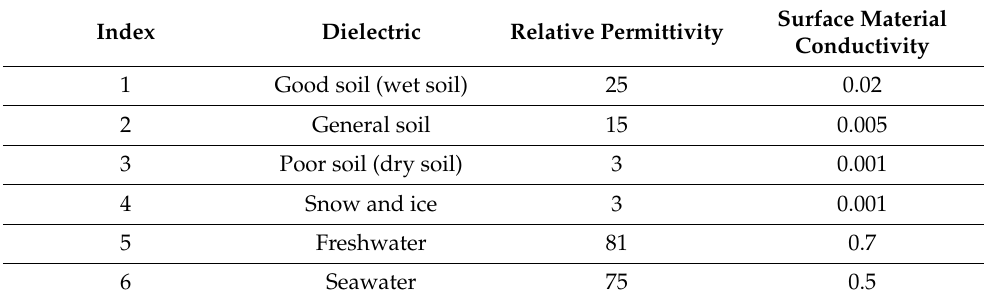
Surface Material Conductivity